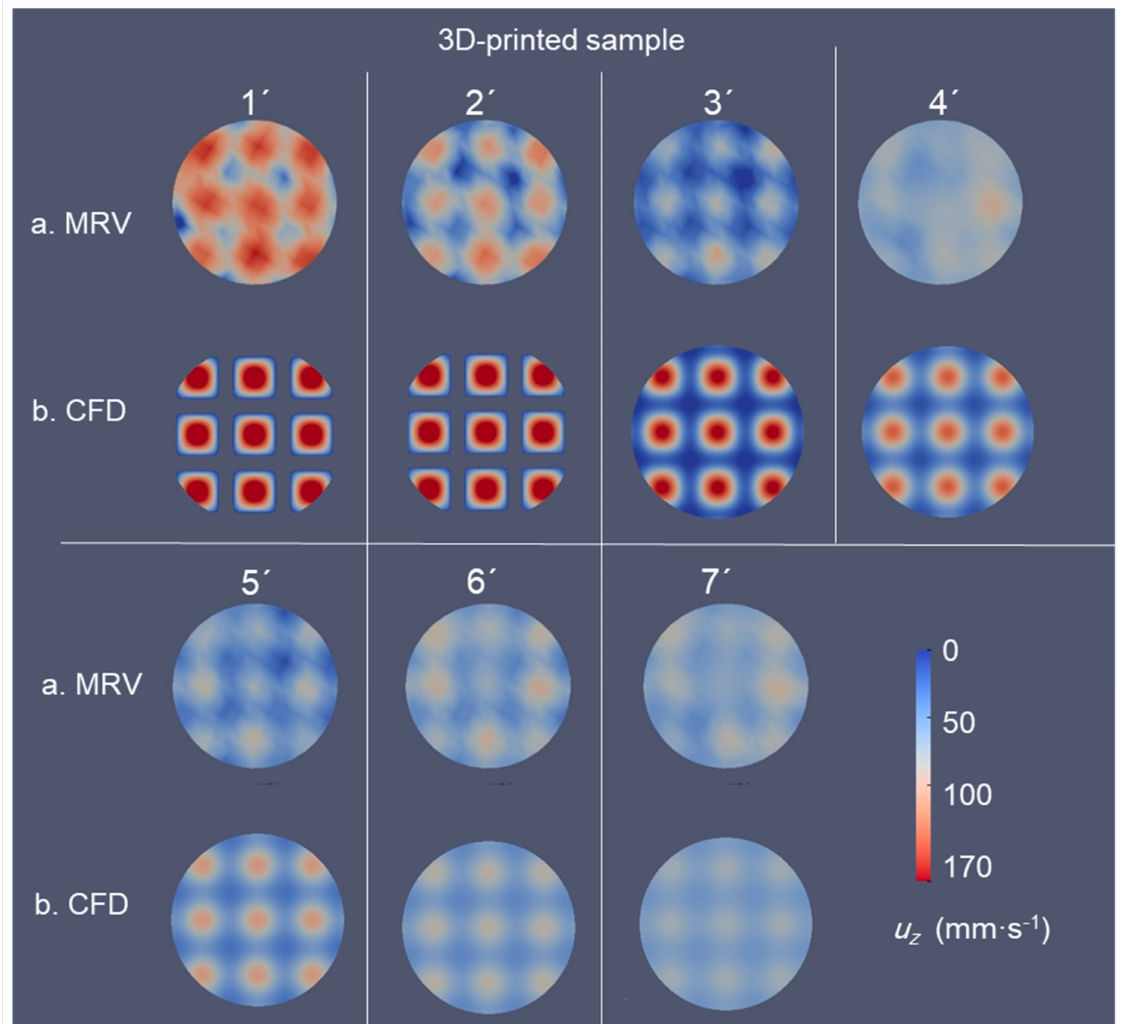
Figure 13. Axial velocity distribution along the exit region within ROI(1) as determined by MRV. The slice numbers correspond to the illustrated markers at the entrance region in Figure